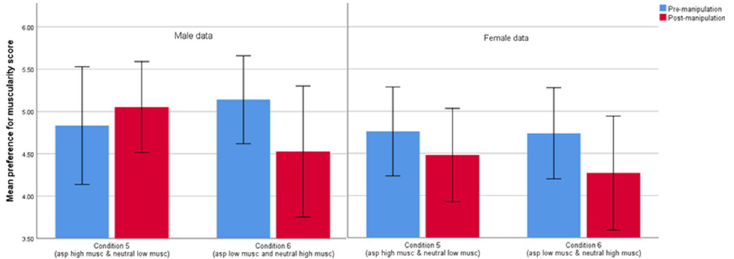
Fig 4. Mean preference for muscularity score for the pre- and post-manipulation preference phases for each of the 2 experimental conditions split by gender where 3.50 represents no preference to either image presented.